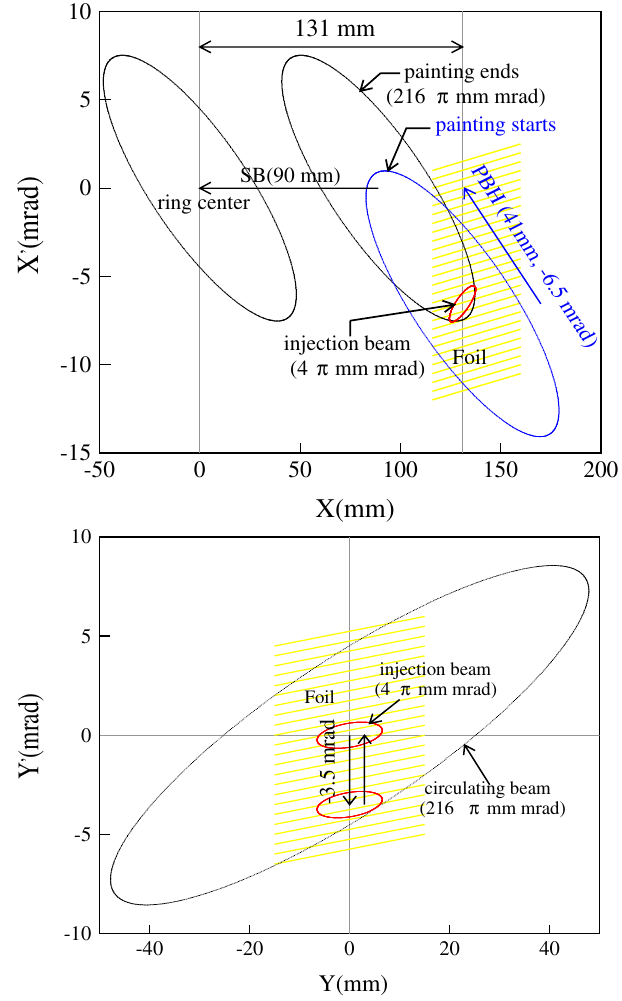
FIG. 3. (Color) Schematic diagrams of the painting injection process performed in the RCS in the horizontal (top) and vertical (bottom) directions with typical design parameters. In the verti- cal direction, the injection beam can be painted either center to outside or outside to center for so-called correlated or anticorre- lated painting, respectively.